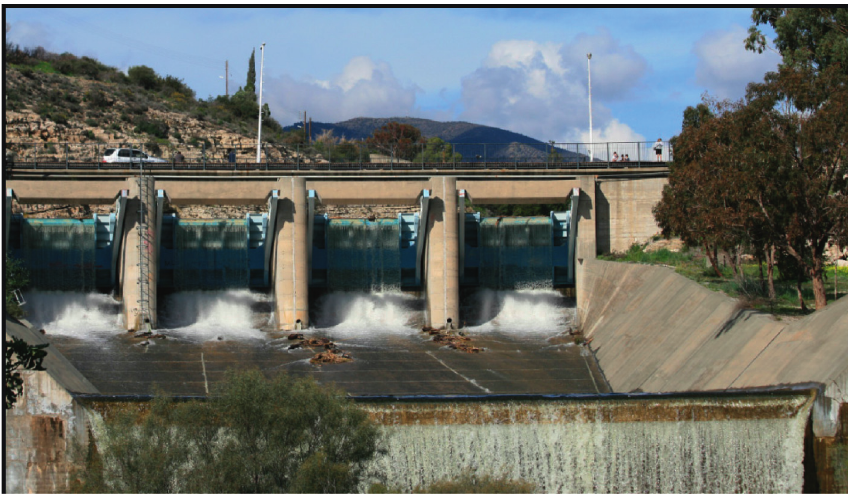
Figure 1: Panoramic view of ladder-shaped